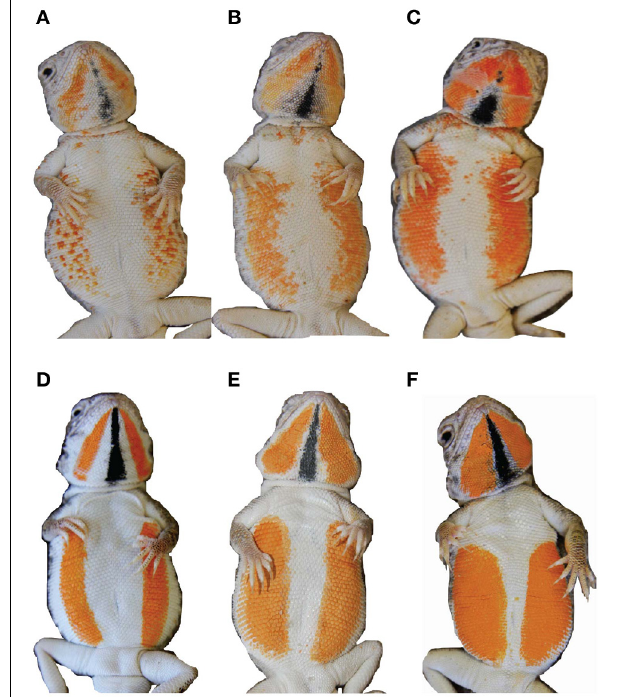
orange. There is no natural analog for the no-UV-orange treatment, which appears the same as the orange treatment to the human eye. The second row of images shows the corresponding paint treatments (D) small patch (E) pale (F)